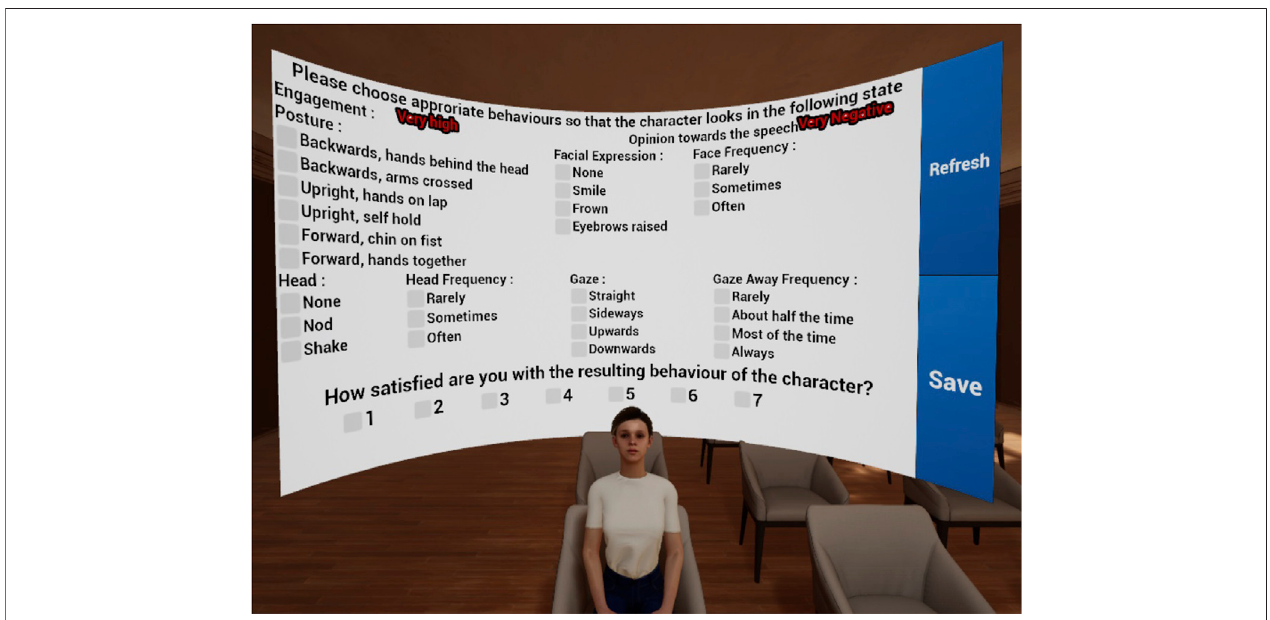
FIGURE 3 | Participant ’ s view during the design of a spectator ’ s